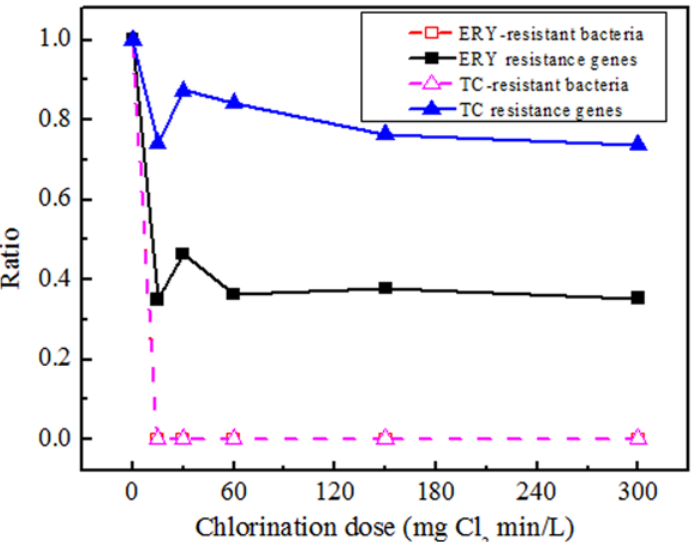
Fig 4. Ratio curves for ERY- and TC- resistant bacteria and genes under a series of doses (mg Cl 2 min/ L). Ratio = N i / N 0 , where N 0 : Initial concentrations of ERY- or TC- resistant bacteria or genes in samples before chlorination; N i : Concentrations of ERY- or TC- resistant bacteria or genes in samples treated by chlorination at a certain dose.